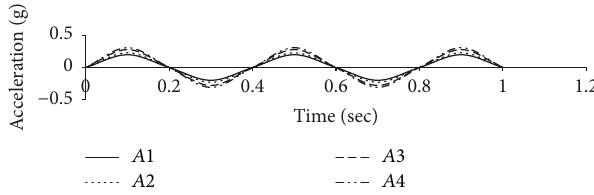
Figure 7: Acceleration history of accelerometers placed at different elevation of a typical soil slope with 45 ∘ inclination, frequency